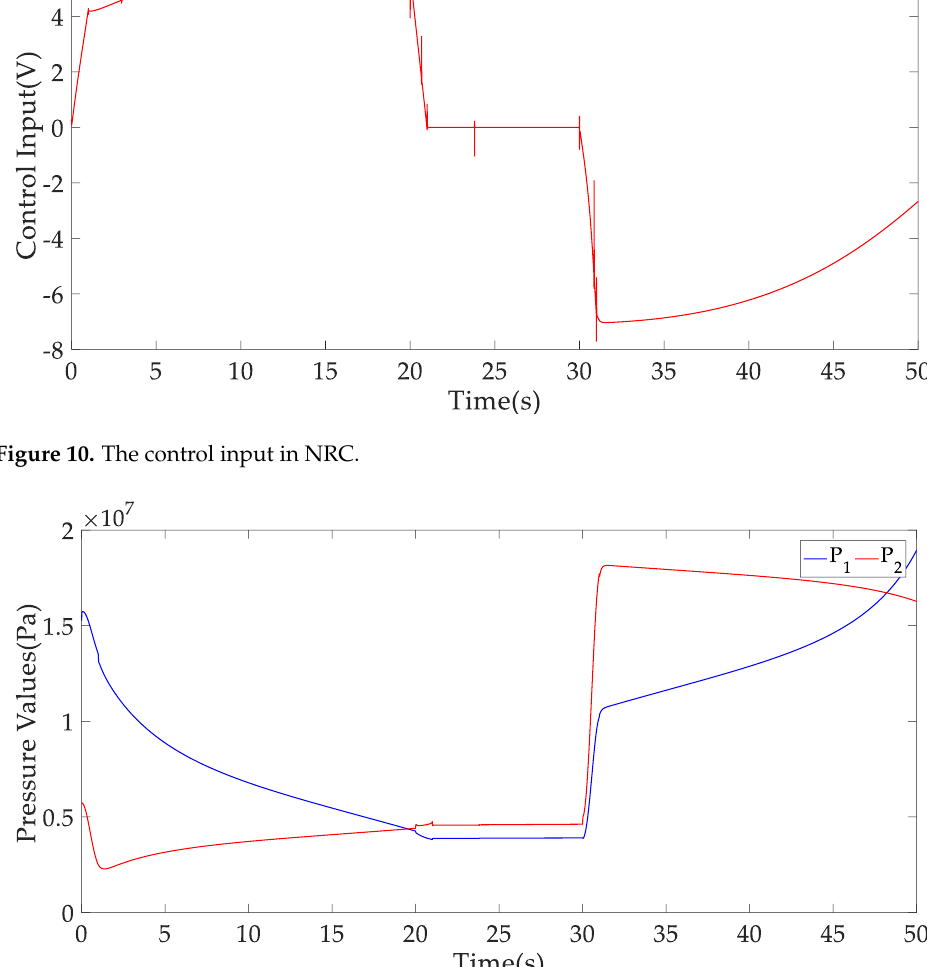
Figure 12. The cylinder force in NRC. 5. Conclusions